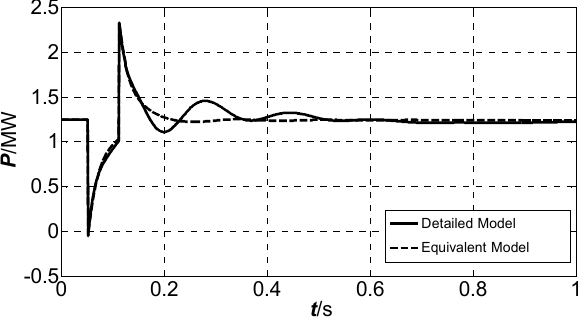
Figure 13. The active power dynamics of the detailed model and the equivalent model under condition C.